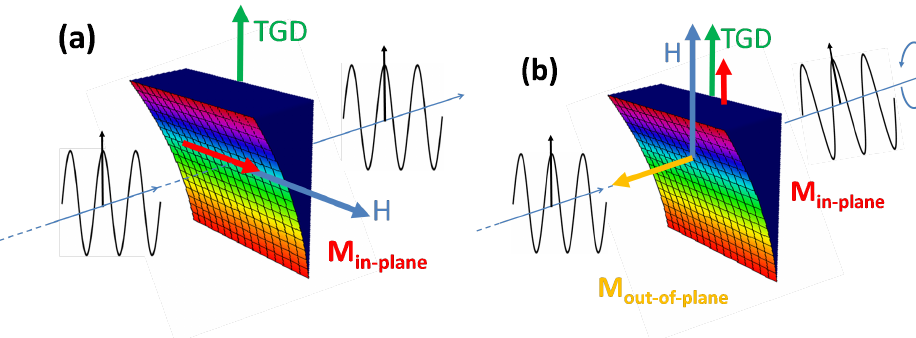
Figure 11. The colored drawing resembles a 3D graph of a Co nanocluster assembly displaying a thickness gradient. Color scale bar is the same as shown in Figure 2b. According to shown MOFE results (Figure 9), the sketch ( b ) outlines the rotation of the E polarization plane in the light transmitting across that 2D assembly, when H is applied along its thickness gradient (M out (cid:54) = 0). Contrarily, in the sketch ( a ) and for the incoming beam at the same point, MOFE vanishes as H is perpendicular to the thickness gradient (M out =